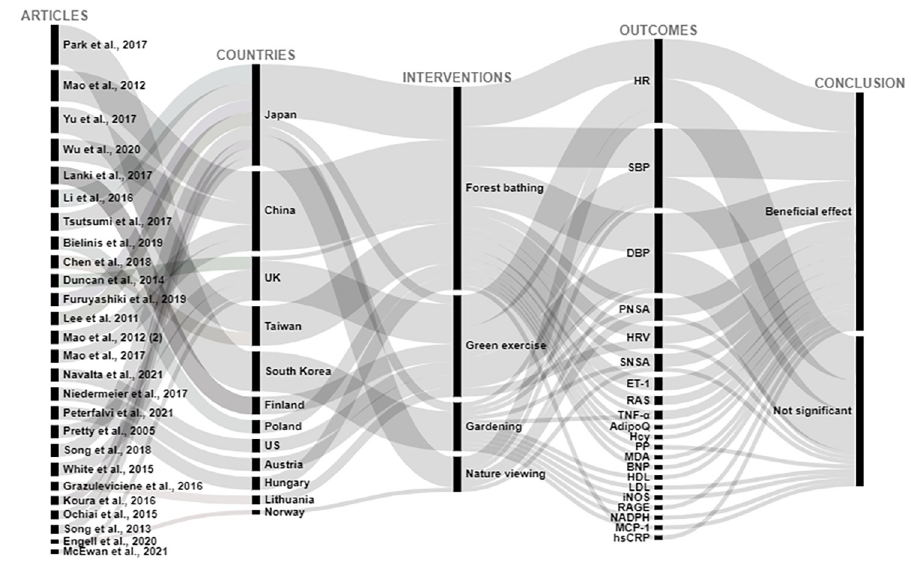
Fig 2. Impact of greenspace or nature based interventions on CV health outcomes. The first column represents articles, the second column represents geographical settings of studies, the third column represents specific interventions used in the studies, the fourth column represents the measures of CV health, while the fifth column represents the conclusion in terms of protective effects ( Beneficial effect ), or no significant results ( Not significant ). This graphical representation shows an overall trend in findings across all studies included. Acronyms : SBP 1 : Systolic blood pressure; DBP 2 : Diastolic blood pressure; BNP 3 : Brain natriuretic peptide; HRV 4 : Heart rate variability; RAS 5 : Renin- angiotensin system components; PNSA 6 : Parasympathetic Nervous System Activity; SNSA 7 : Sympathetic Nervous System Activity; hsCRP 8 : High sensitivity C-reactive protein; TNF- α 9 : Tumor necrosis factor alpha; HR 10 : Heart rate; MDA 11 : Malondialdehyde; RAGE 12 : Receptor for advanced glycation end products; iNOS 13 : Inducible nitric oxide synthase; MCP-1 14 : Monocyte chemoattractant protein-1; ET-1 15 : Endothelin-1; PP 16 : Pulse pressure; AdipoQ 17 : Adiponectin; Hcy 18 : Homocysteine; NADPH 19 : NADPH oxidase p47; HDL 20 : High-density lipoprotein; LDL 21 , and Low-density